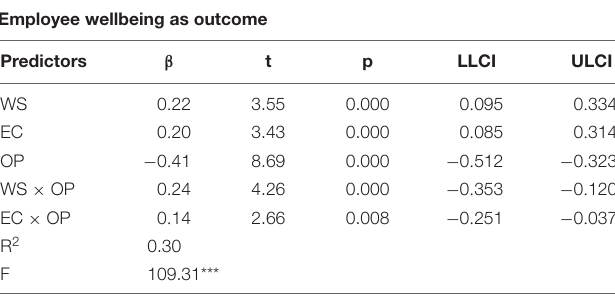
TABLE 2 | Testing the mediating effect of EC and moderated-mediating effect of OP and